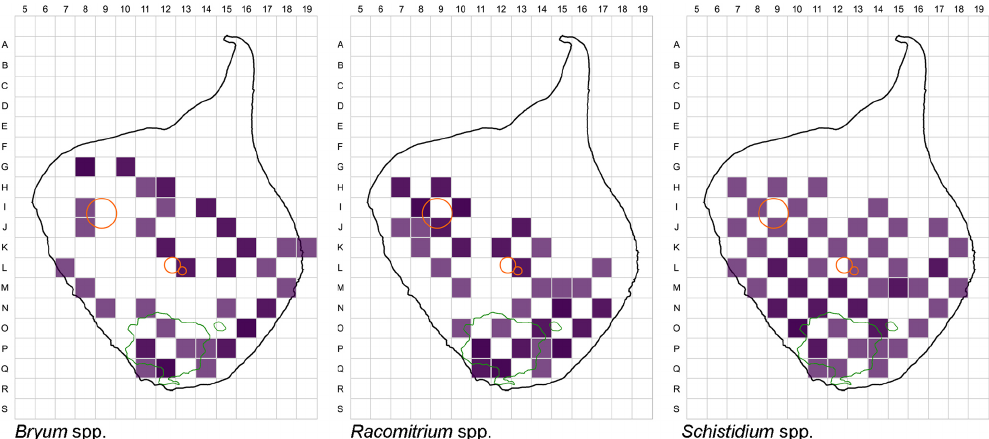
Figure 2. Distribution of the most common genera on Surtsey: Bryum, Racomitrium and Schistidium . Each species or taxa layer has 70% colour opacity; darker colour indicates more species and lighter colour fewer species. Maps: Anette Meier and GVI.